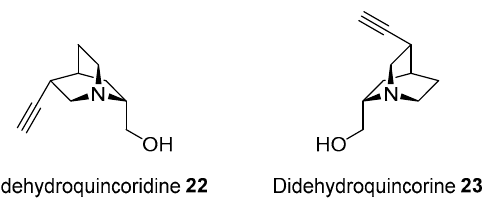
Figure 3. Didehydroquincoridine 22 and didehydrocincorine 23 , Cinchona alkaloid based compounds.